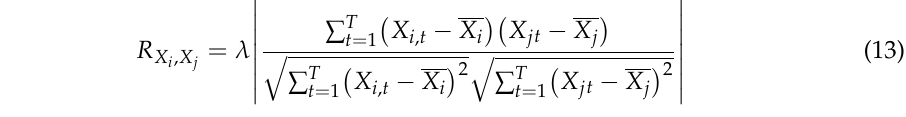
Algorithm 2: Pseudocode for updating the parent node sets π g For each node g = 1, . . . ,